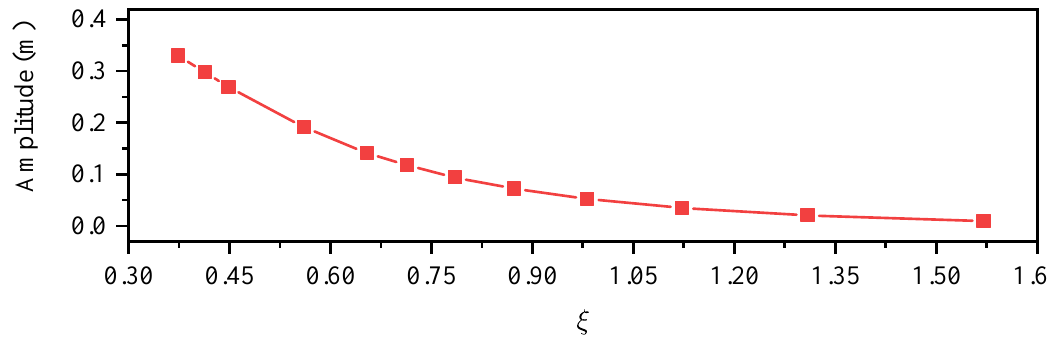
Figure 12. Numerical results of the first-order harmonic amplitude of the transmitted wave by imposing incident waves of different wave angular